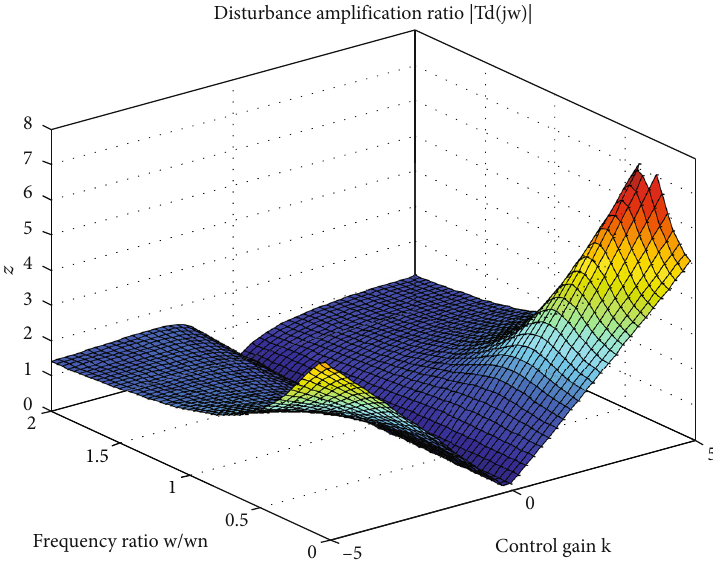
Figure 1: Dependence of disturbance ampli fi cation upon control gain and frequency